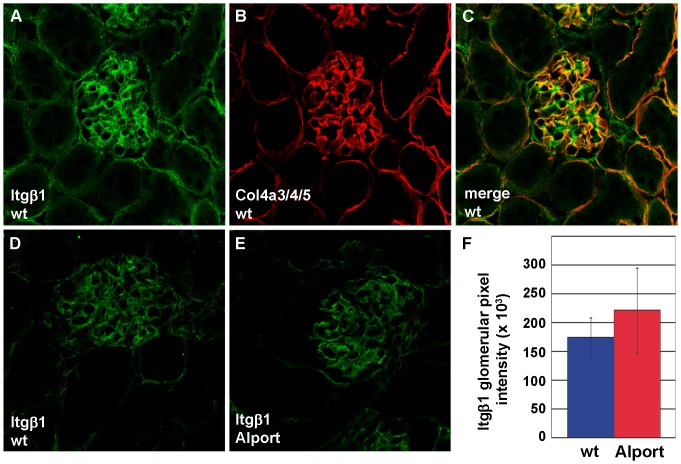
There is no change in expression of integrin β1 in Alport glomeruli.A–C: Fresh frozen kidney sections from 4 week old wild-type (wt) mice, immunolabeled with anti-integrin β1 (A), anti collagen α3α4α5(IV) (B) and overlap of labeling is shown in C (merge). D–F: Representative fluorescence micrographs of wildtype (D) and Alport glomeruli immunolabled with anti-integrin β1. Glomerular fluorescence intensities were averaged for n = 3 mice of each genotype, wild-type (wt, blue) or Alport (red), and there is no statistical difference.